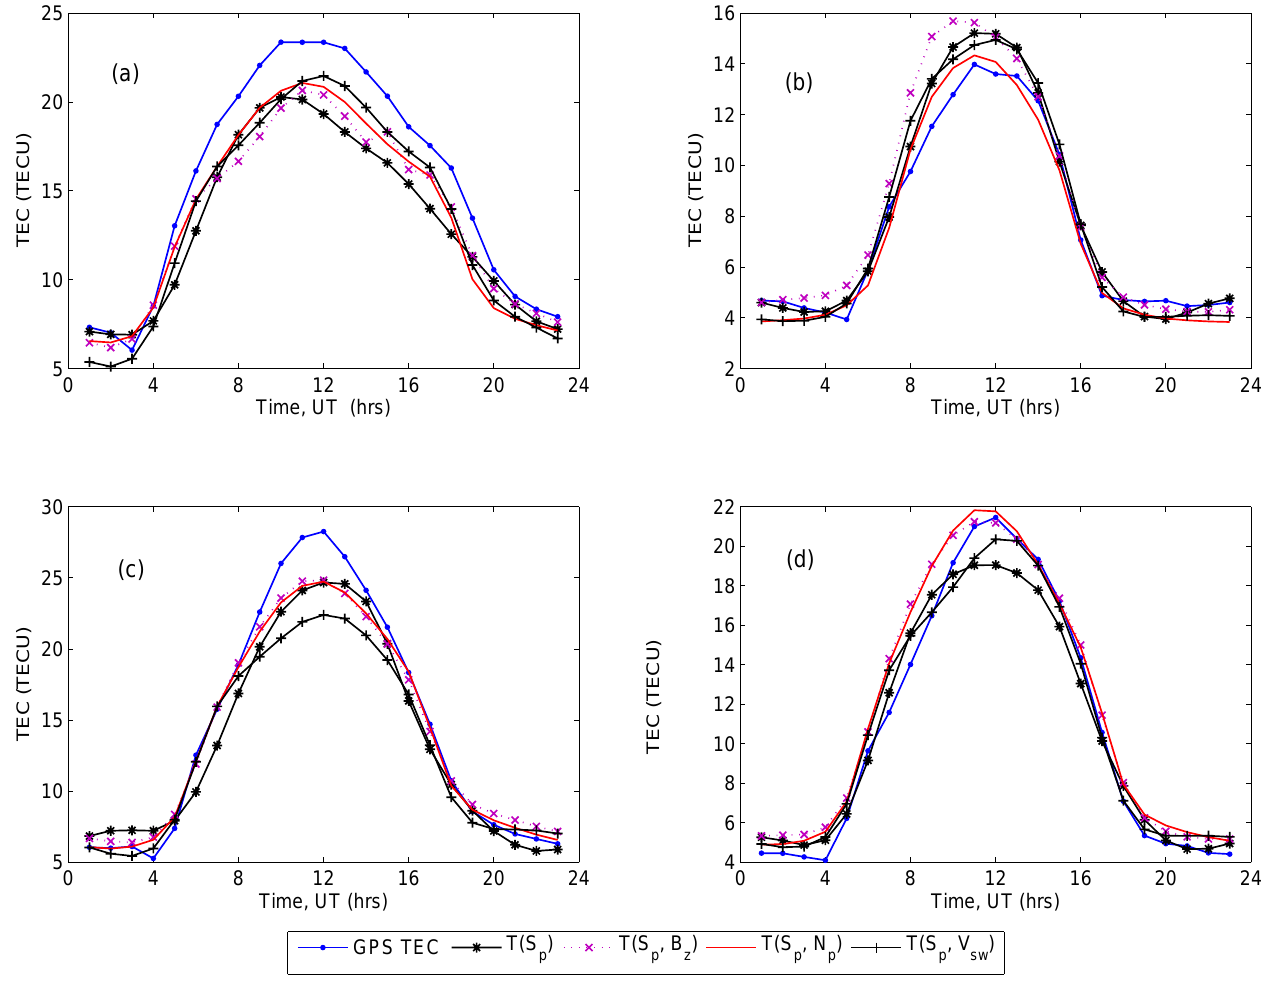
Fig. 12. A plot of monthly average GPS TEC for each hour and the corresponding predictions with all parameters used for the months representing (a) summer (January), (b) winter (June), (c) autumn (March) and (d) spring (September) in 2005.